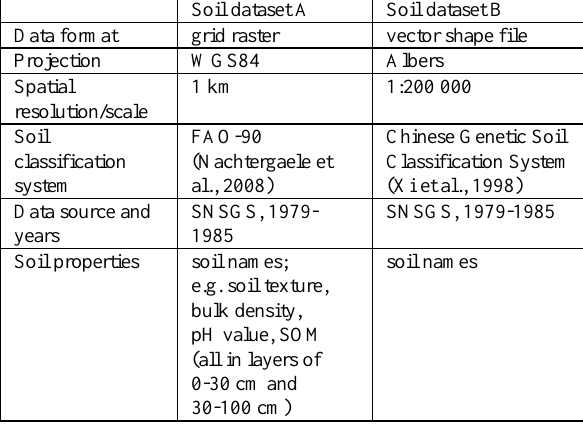
Table 1. Comparison of the soil data